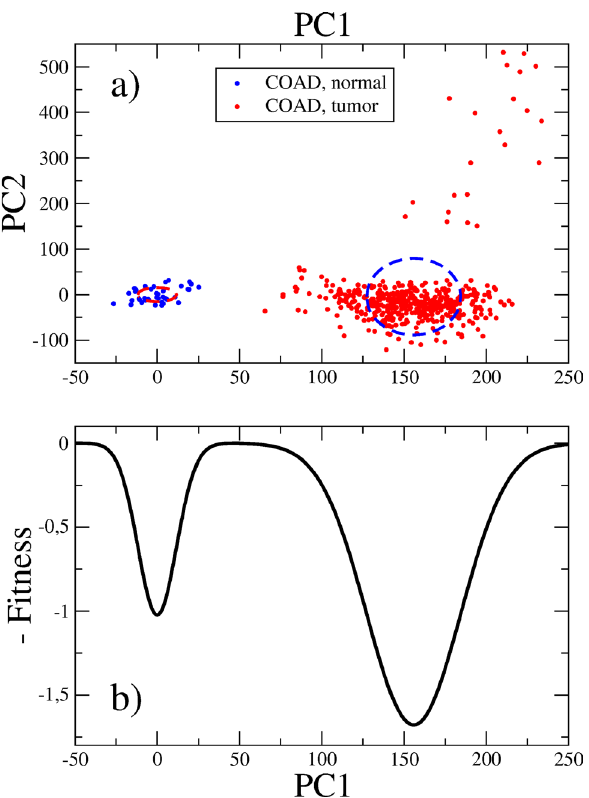
Figure 1. ( a ) PC analysis of the GE data for adenocarcinoma of the colon. Normal (blue circles) and tumor samples (red circles) are shown. Ellipses illustrating the centers and r.m.s. radii of both clouds of points are drawn. ( b ) Schematics of the fitness landscape. The fitness is normalized to the homeostatic value. The tumor region exhibits the deepest well (highest